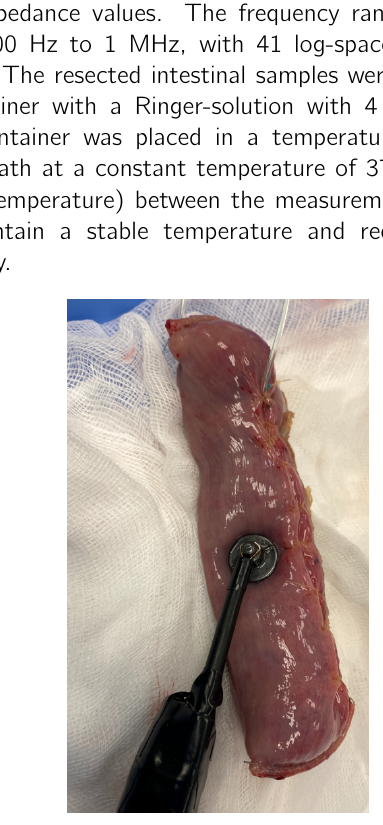
Figure 1: Experiment set-up. Human intestine sample under